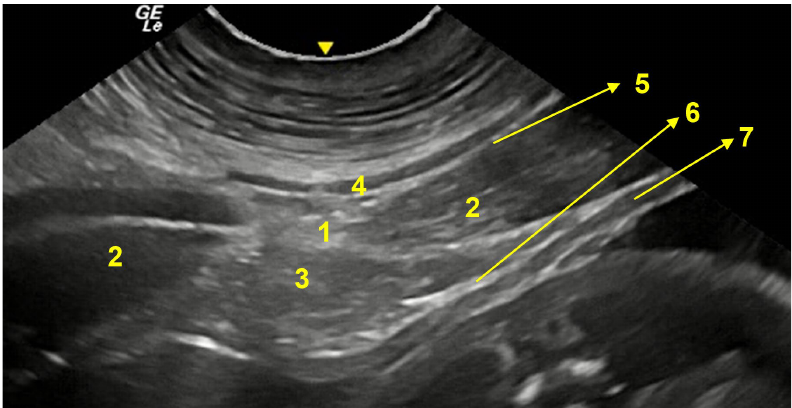
Figure 11. Schematic drawing showing the abdominal regions encompassed by ultrasonography: A. pre-umbilical region; B. umbilical region; C. post-umbilical region. Image created in BioRender.com by Flavia Maria Pia Montenegro Donoso.